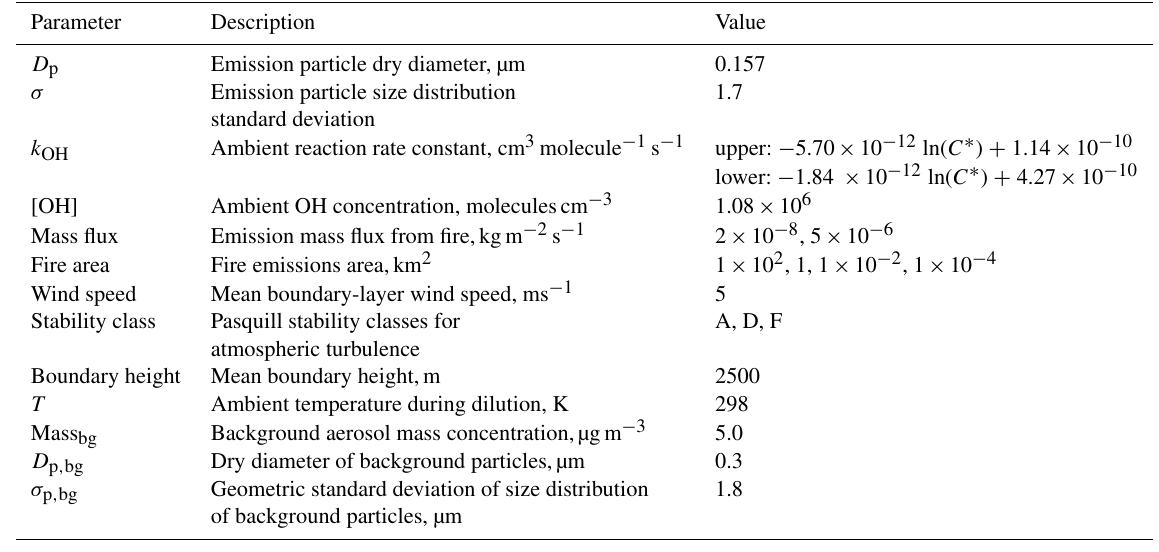
Table 3. Input parameters for the ambient-plume Gaussian dispersion simulations.